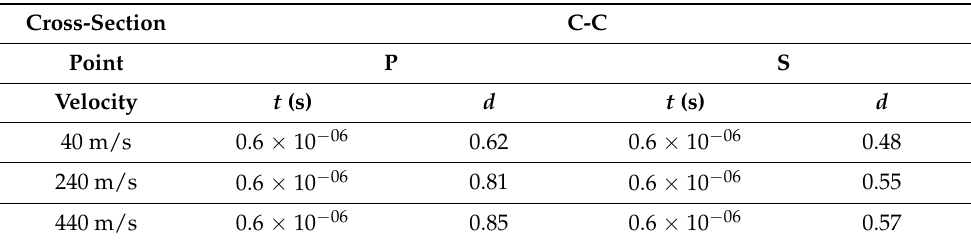
Table 3. Time instance (s) when damage appears at observed points and the damage value, cross- section